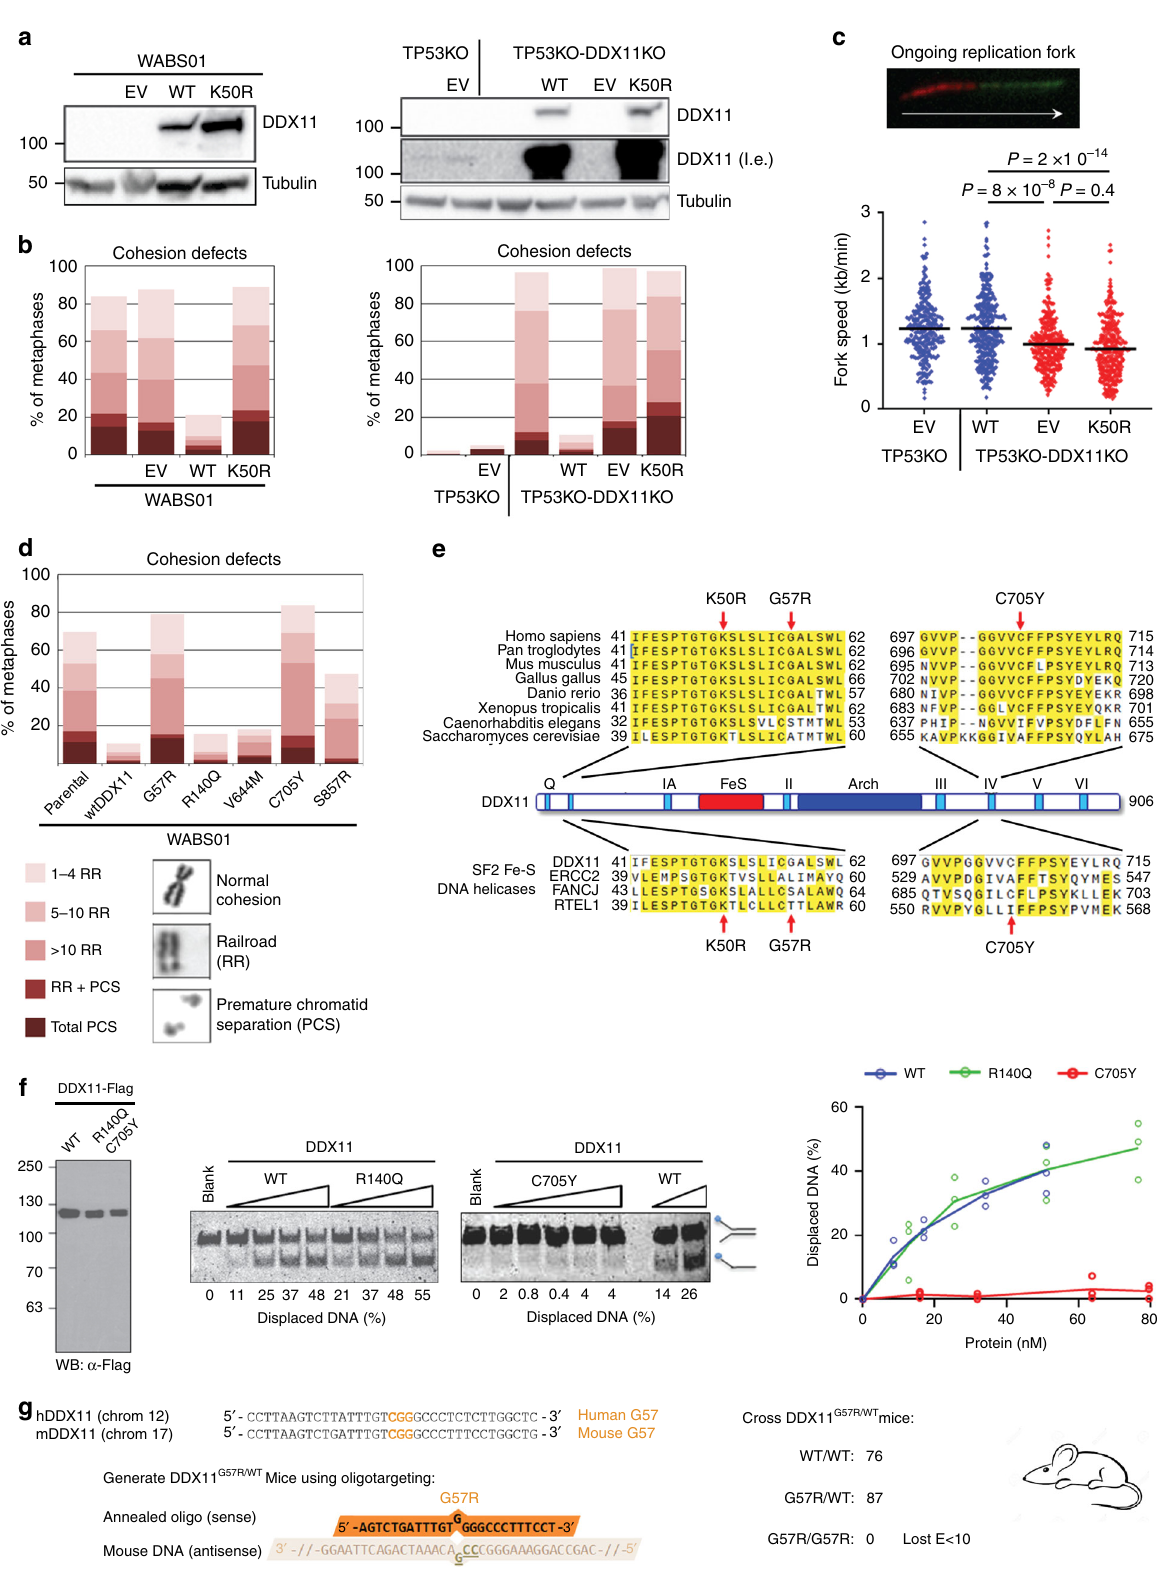
null allele (Fig. 8g). Taken together, we conclude that the DNA helicase domain of DDX11 facilitates normal DNA replication, to prevent DNA damage and cohesion loss, presumably by resolving G4 structures that arise when replication forks travel through G- rich